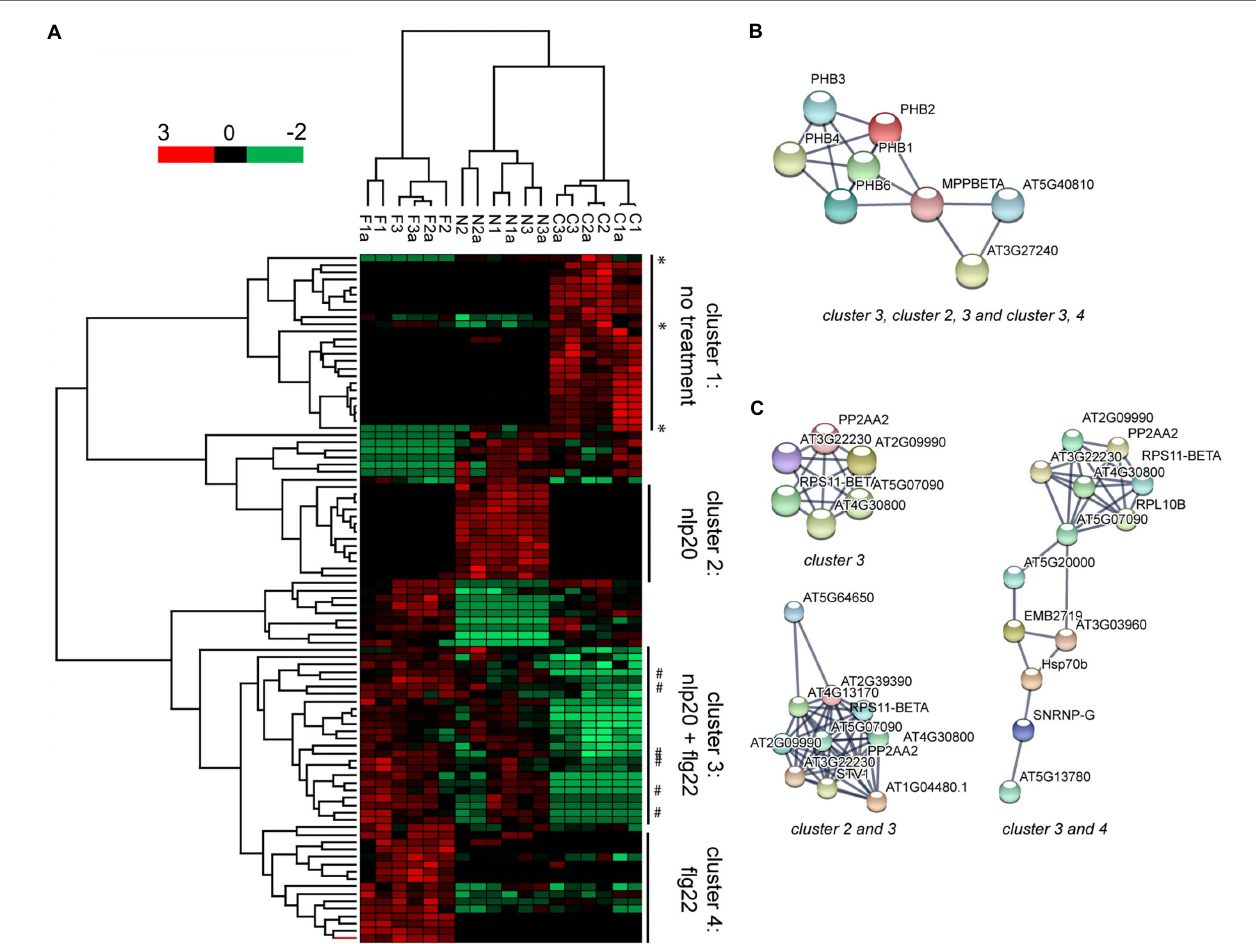
FIGURE 3 | Ninety-three proteins showing significant changes in their abundance in the nuclear protein fraction following flg22 or nlp20 treatment. Multiple sample significance testing (ANOVA) was done, with false discovery rates (FDR) multiples testing corrected significance threshold α = 0.05. (A) Hierarchical cluster analysis (HCL) shows clustering of samples according to sample type. Rows represent proteins. PQI values were z -score transformed. Proteins are colored according to their abundance. * denotes decrease in abundance under effect of only flg22 or nlp20. # denotes increase in abundance under effect of flg22 only. F: flg22 treated, N: nlp20 treated, C: control (untreated), and a: technical replicate. (B) STRING database binary protein interaction network of Prohibitins with Cytochrome C generated when indicated clusters were used as input sets. (C) STRING database interaction networks of ribosomal and associated proteins when indicated clusters were used as input sets. String search was done using experiments, databases, co-occurrence and co- expression as interaction sources and showing only interactions between proteins in the input set. Edges in the string interaction network indicate both functional and physical protein